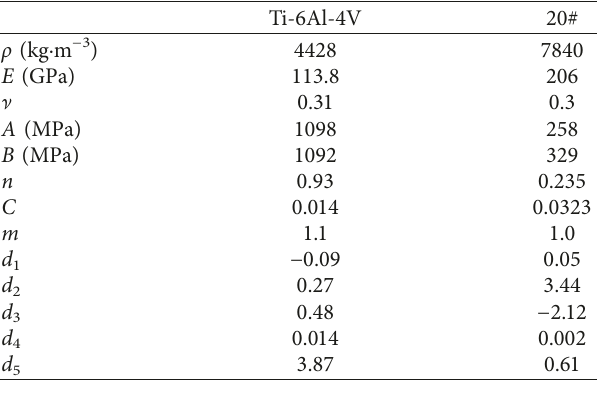
Table 2: Material